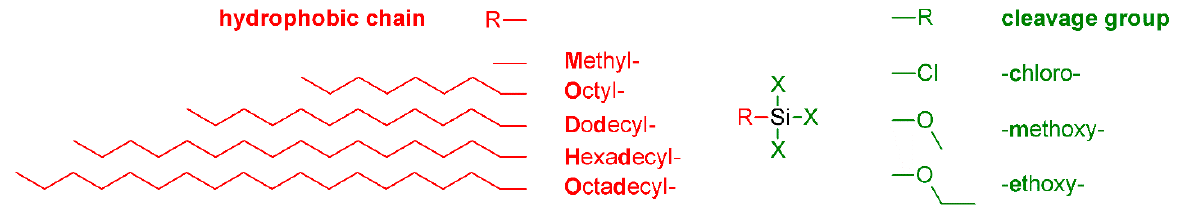
Figure 2. Typical functional groups for hydrophobic silanes.